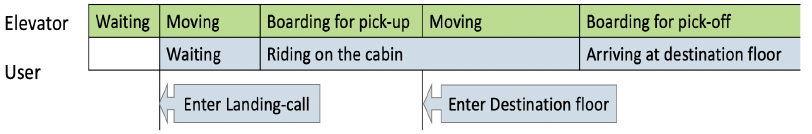
Figure 8. The state transitions of both the elevator and